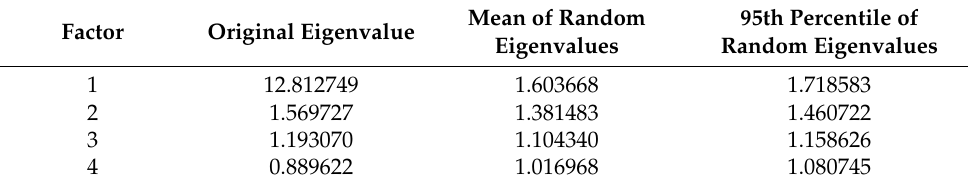
Table 3. Results of parallel